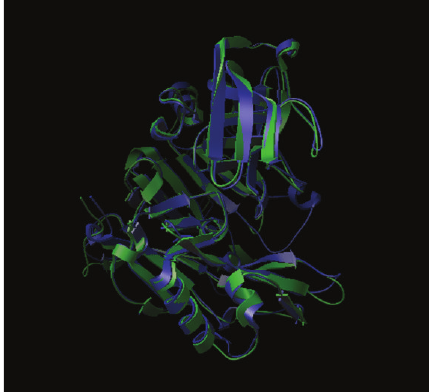
Figure 4: Superimposition of chain A of crystal structures of BACE1 (1FKN) and BACE2 (2EWY), where BACE1 is coloured blue and BACE2 is coloured